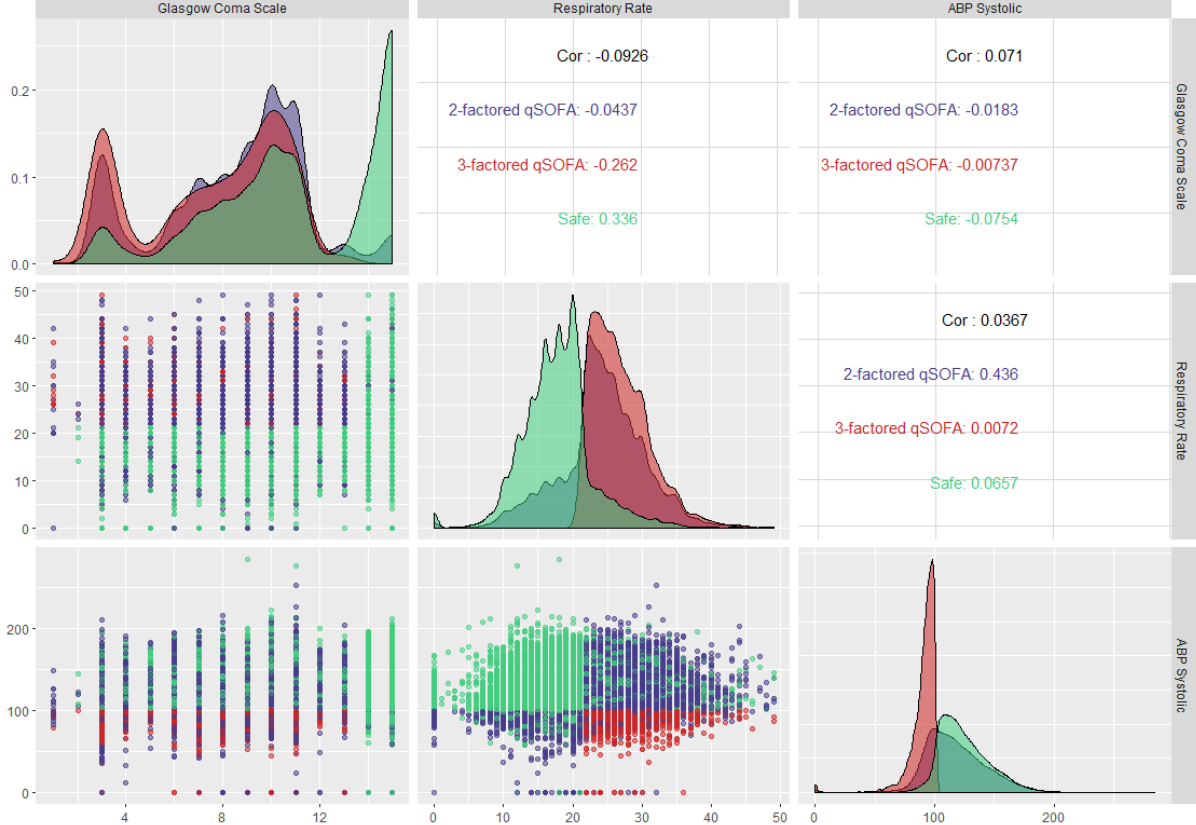
Figure 4. Facet grid illustration of sepsis-3 (qSOFA) parameters to capture the underlying relationship between parameters and the most prevalent sepsis scenario in the intensive care unit. qSOFA: quick Sequential Organ Failure Assessment.